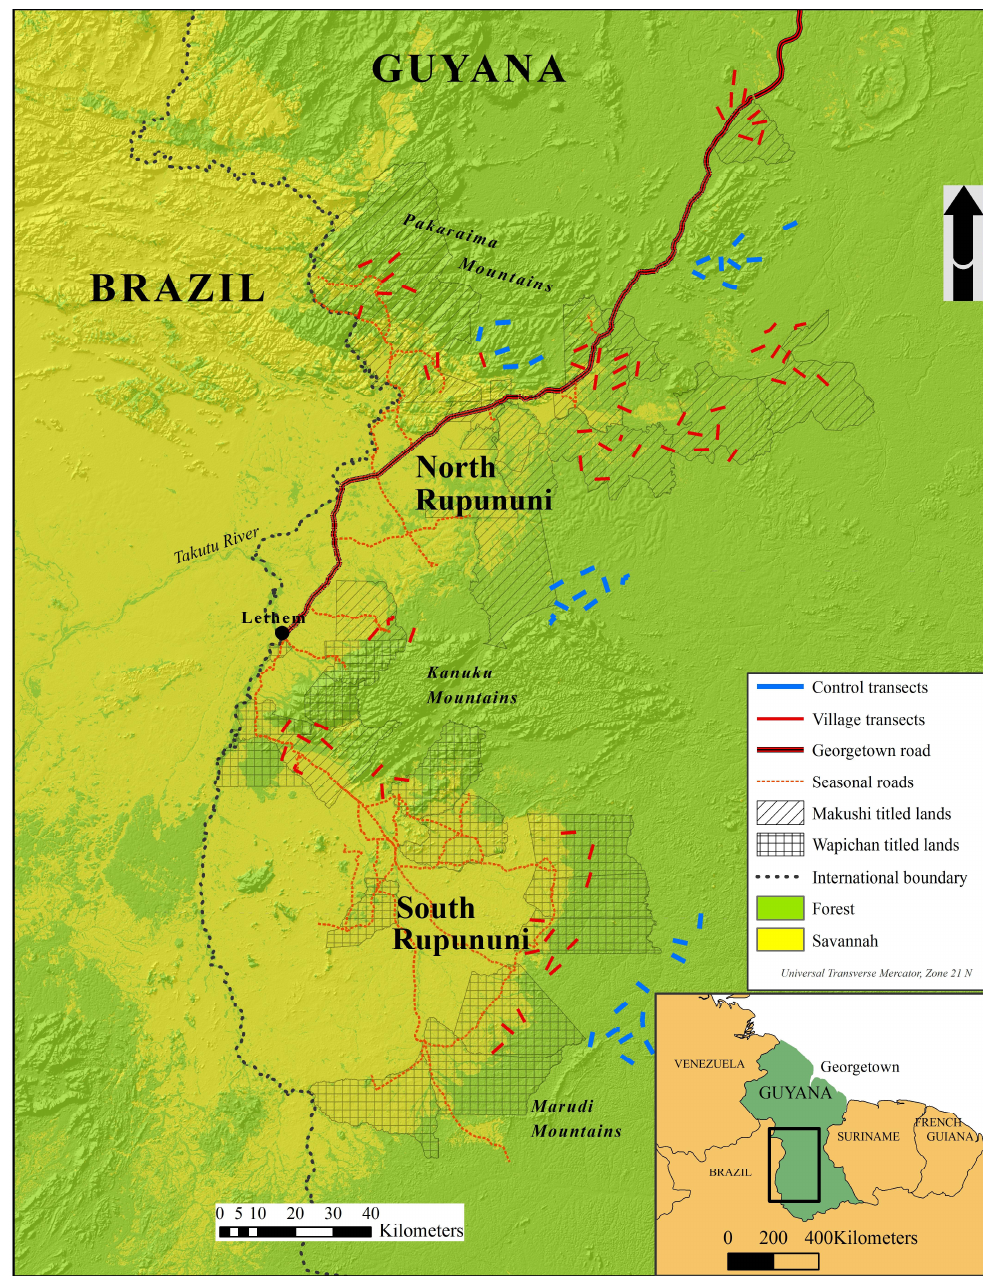
Figure 1. Study area with savannah and forest cover, indigenous titled lands, and village and control transects where biomass was estimated.